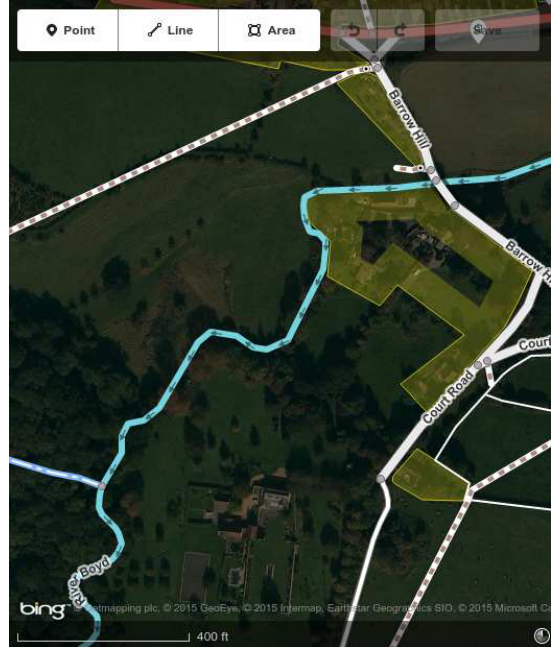
Figure 2: A screenshot of the ID editor for OpenStreetMap. This is one of a wide range of web-based and desktop-based editing software for